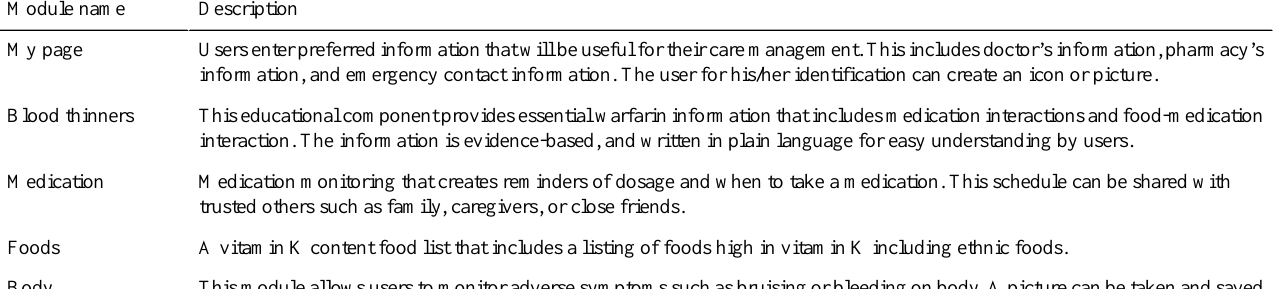
Table 4. Modules included in the warfarin therapy app for older adults, mobile app for savvy seniors (MASS), happy and safe life with blood thinners. DescriptionModule